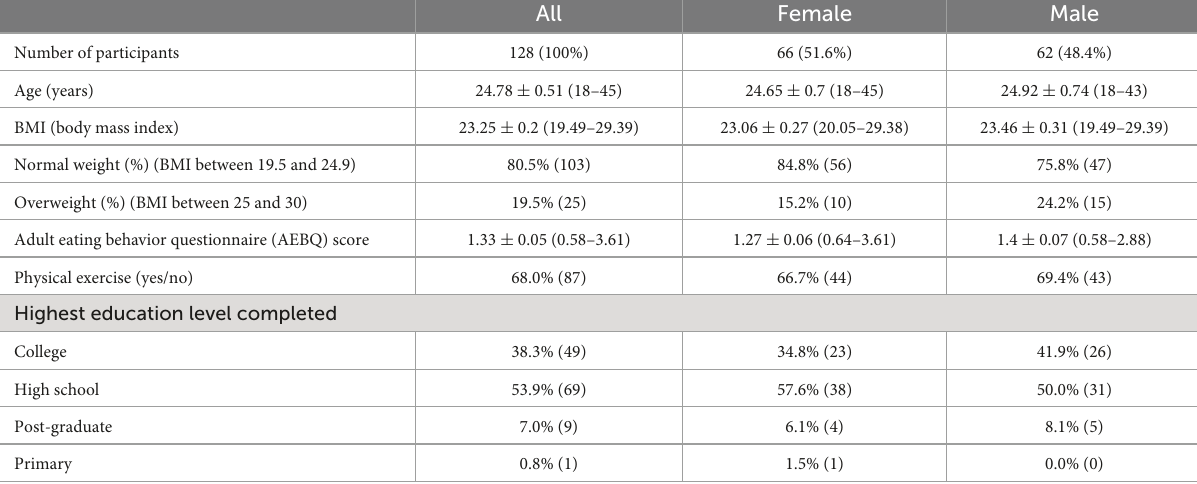
TABLE 1 Participant demographic